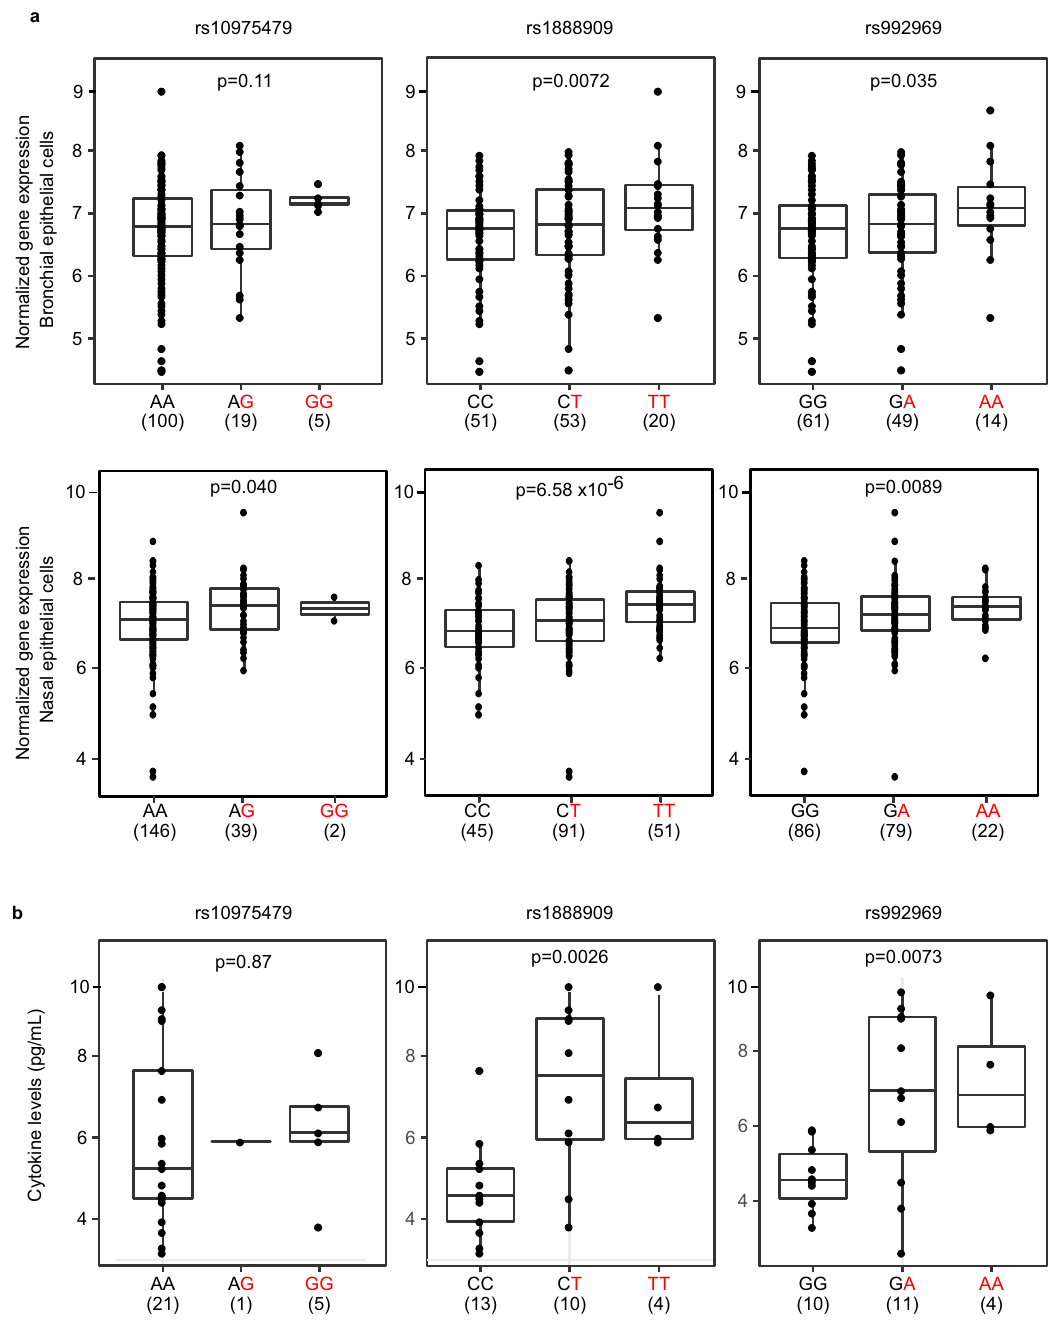
Fig. 5 The rs1888909 (T) and rs992969 (A) alleles are associated with increased IL33 expression and IL-33 protein levels. a Comparison of IL33 expression between genotypes for SNPs rs10975479, rs1888909, and rs992969 from bronchial epithelial cells from 124 asthmatic and non-asthmatic adult subjects, mostly of European ancestry (upper panels) and nasal epithelial cells from 189 African-American children from high risk asthma families (lower panels). b Comparison of IL-33 cytokine levels between genotypes for SNPs rs10975479 ( n = 27), rs1888909 ( n = 27), and rs992969 ( n = 25) measured in plasma from Hutterite children (all European ancestry). The asthma-associated risk allele at each SNP is highlighted in red ( x- axis). The number of subjects per group is shown below the genotype. Boxplot center line: median; box limits: upper and lower quartiles; whiskers: 1.5× interquartile range. Statistical signi fi cance was determined using an additive linear model. Source data are provided as a Source Data fi